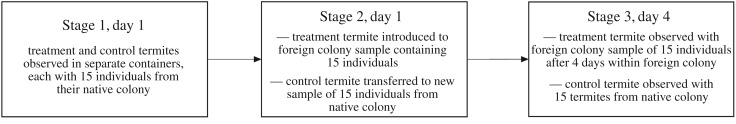
Design and sequence of the experiment.